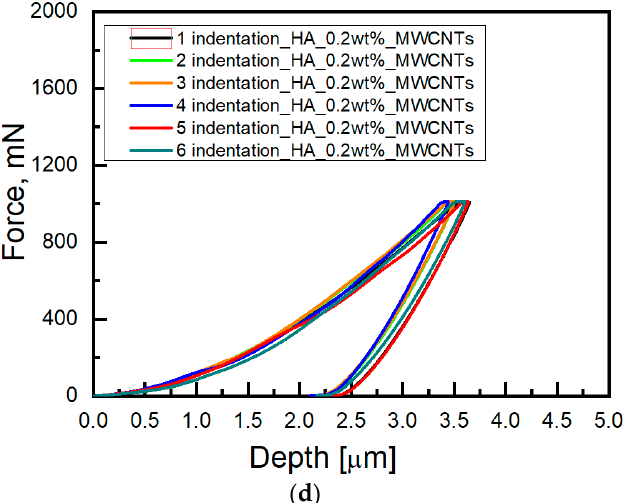
Figure 5. Load vs. displacement plot for HA ( a ) and HA/MWCNTs composites with the amount of MWCNTs additives: 0.05 wt% ( b ), 0.1 wt.% ( c ) and 0.2 wt.% ( d ). Each Figure 5a–d shows the load vs. displacement plots for 6 indentations in the sample.